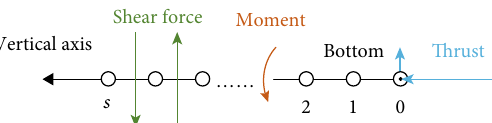
Figure 1: Illustration of normal load, axial load, shear force, and bending moment.